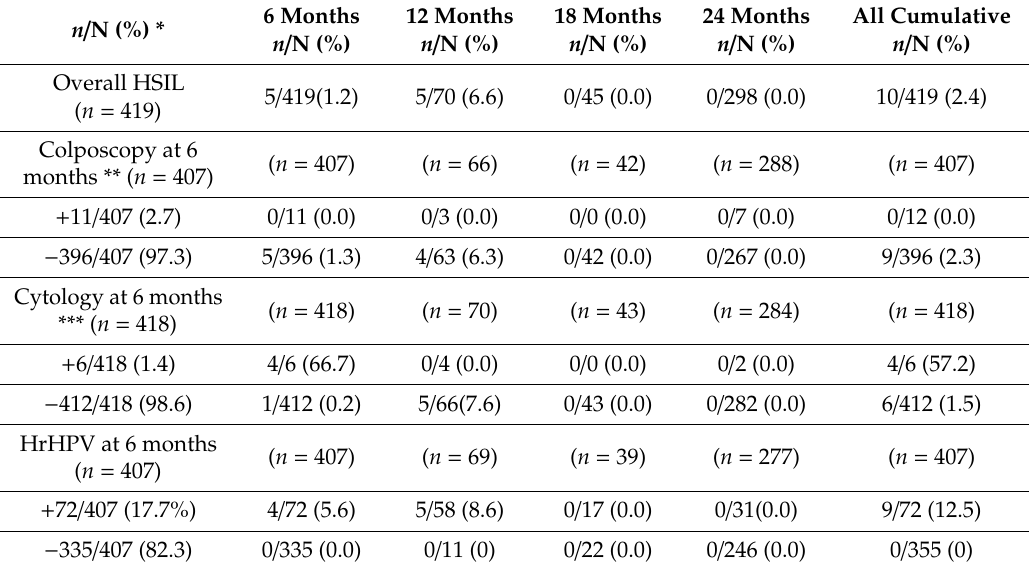
Table 2. Recurrence of HSIL for women with HSIL as worst histology, repeat LLEZT excluded.